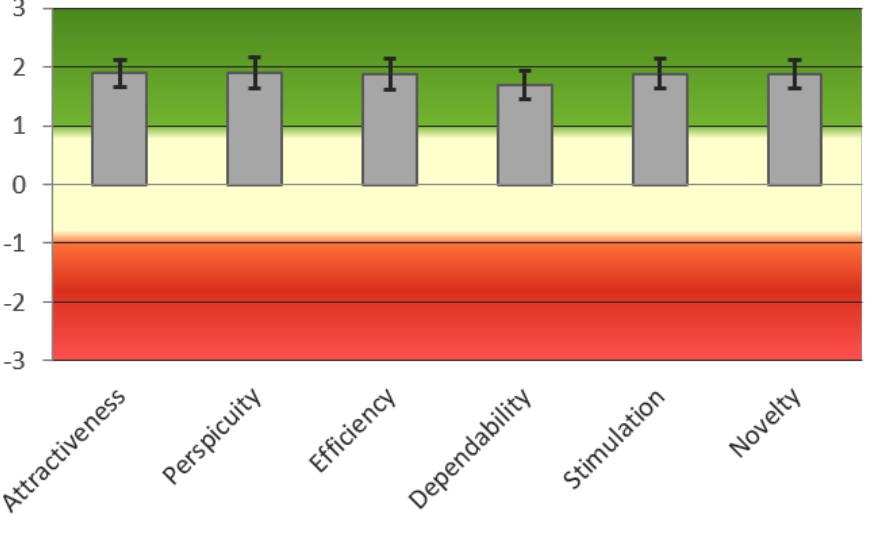
Figure 9. MIRA user experience questionnaire resulting scores on six dimensional scale.